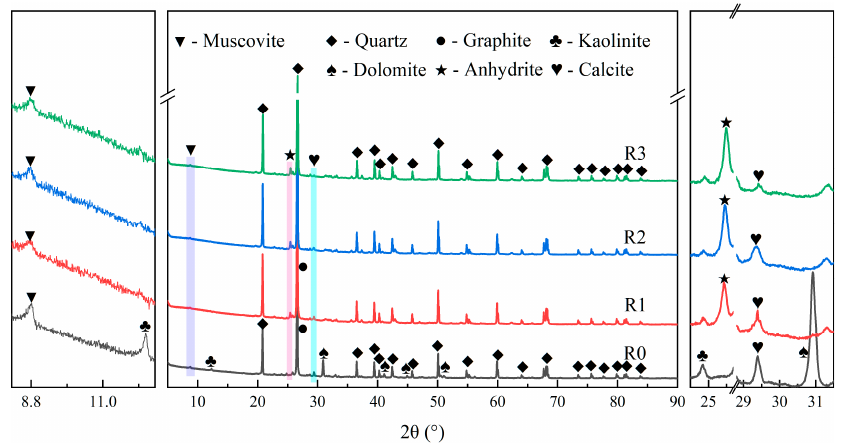
Figure 11. XRD patterns of samples: R0-raw ore, R1-product pre-roasted for 40 min, R2-product roasted at 650 °C, and R3-product roasted under optimal conditions.